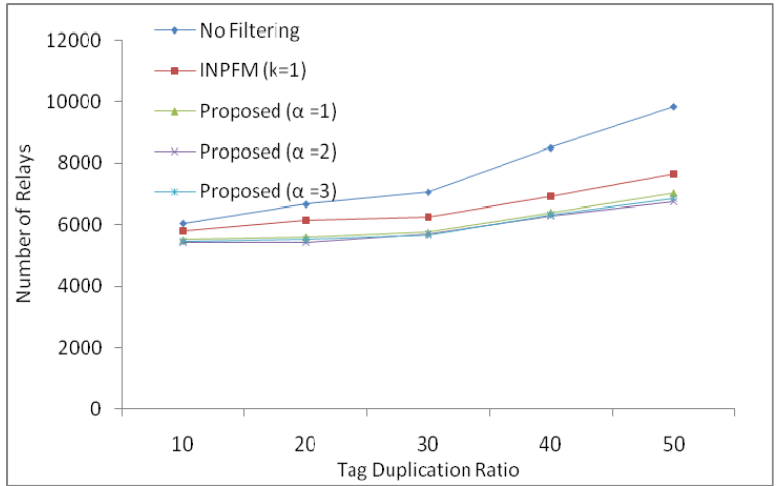
Figure 10. Number of relays with value of α